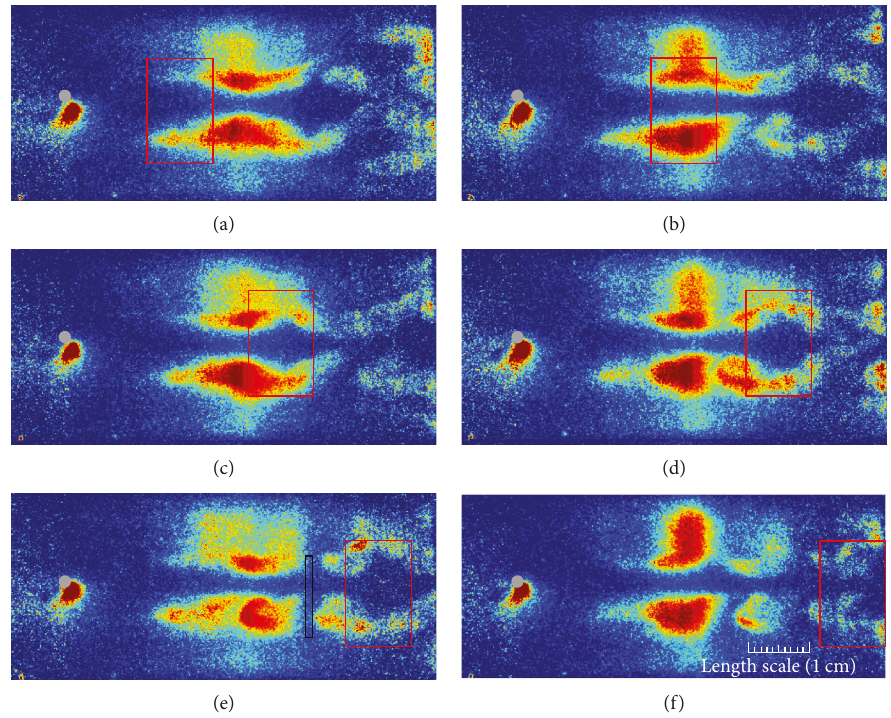
Figure 6: Wake vortex structure development in fl ow fi eld. Diameter =2mm, Reynolds number =500, and sheet position =3mm. The distance between the cylinder and the slot was 5.9cm. The jet direction was at an angle of 45 ° to the surface of the fl at. The frame rate was